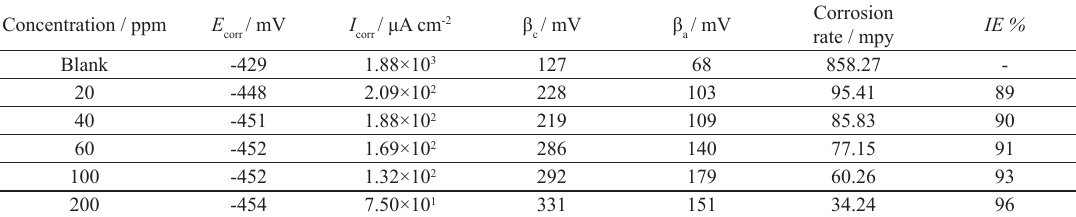
SO solutions in the presence and absence of inhibitor. 2 4